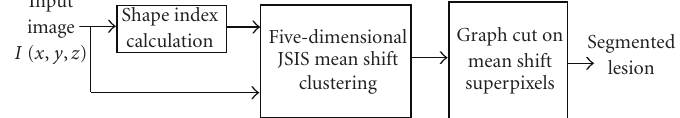
Figure 1: Flow diagram of the proposed graph cut-based method.